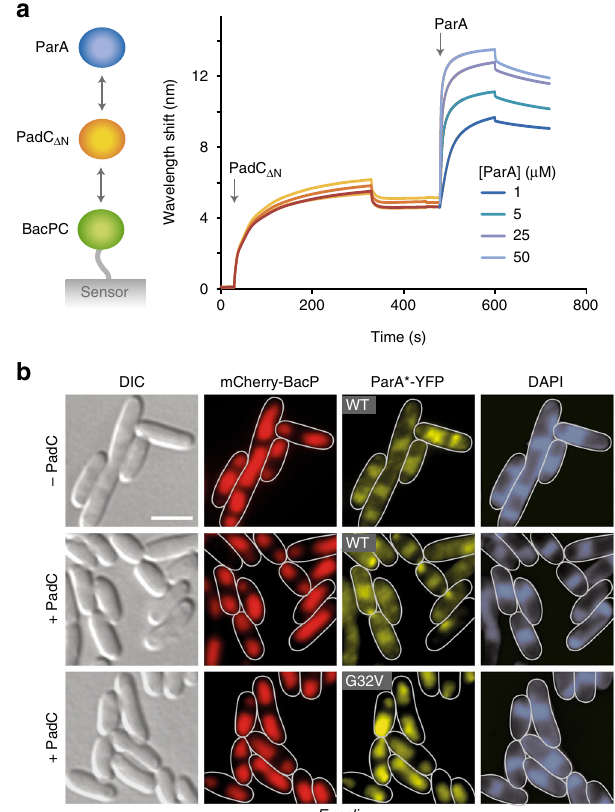
Fig. 6 PadC recruits ParA to bacto fi lin polymers. a In vitro reconstitution of the ternary BacP · PadC · ParA complex. Bio-layer interferometry sensors loaded with biotinylated BacP Δ 1-115 (BacP C ) were fi rst incubated with 5 µ M PadC Δ 1-281 (PadC Δ N ). After the dissociation of loosely bound protein, the sensors were transferred into solutions containing the indicated concentrations of ParA (arrow) to monitor the interaction of ParA with the BacP C · PadC Δ N complex. The extent of non-speci fi c binding of ParA to BacP C -loaded sensors was negligible (Supplementary Fig. 7a). b PadC-mediated recruitment of ParA to bacto fi lin complexes in the heterologous host E. coli . Cells of E. coli BL21(DE3) bearing plasmid pLL54 (P T7 - mCherry-bacP cfp-bacO ) were transformed with plasmid pLL86 (P tet - parA-eyfp ) (WT) or pLL215 (P tet - parA G32V -eyfp ) (G32V) and, when indicated (+PadC), with plasmid pLL205 (P T7 - padC ). Transformants were induced with 0.5 mM IPTG (for 3.5 h) and 0.2 µ g/ml aTet (for 2.5 h) before imaging (bars: 3 µ m). The PCCs for the mCherry-BacP and ParA*-YFP signals are 0.1 ± 0.27 (WT without PadC, n = 115 cells), 0.51 ± 0.23 (WT with PadC, n = 114 cells), and 0.93 ± 0.06 (G32V with PadC, n = 97